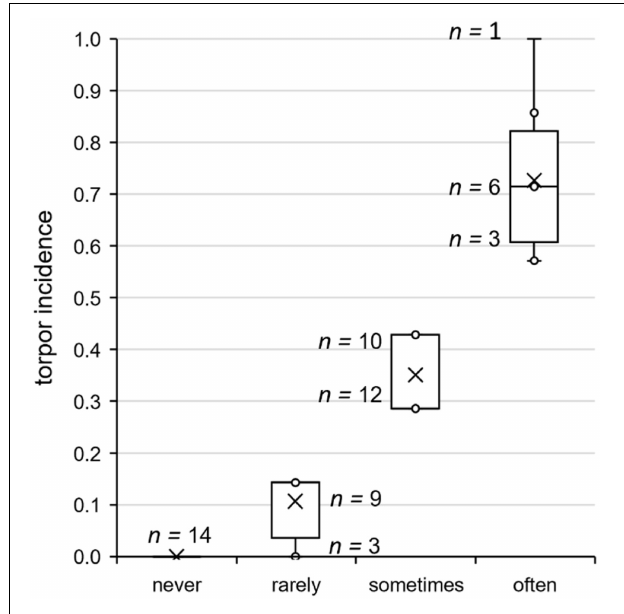
FIGURE 4 | Torpor incidence groups of approach 1. Grouping of all hamsters according to their individual torpor incidence shown in the week of analysis. From the distribution of the torpor incidence values of the hamsters expressing torpor, yet not necessarily during the week of analysis, three groups were derived for phenotyping. Taking the 25th percentile (torpor incidence of 0.2) and the 75th percentile (torpor incidence of 0.5) as thresholds, the animals were assigned to the groups “rarely torpor” ( < 25%, n = 12), “sometimes torpor” (25–75%, n = 22), and “often torpor” ( > 75%, n = 12). The torpor incidence varied between hamsters of the same group, as indicated with the sample sizes per torpor incidence value next to the boxplots . Responders that never expressed torpor during their individual implantation time accounted for the fourth group “never torpor” ( n = 14).